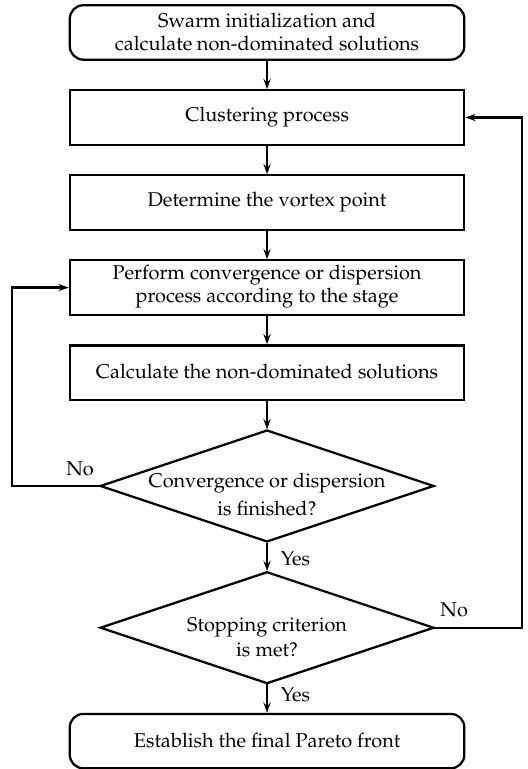
Figure 7. Proposal of MOVPSO using